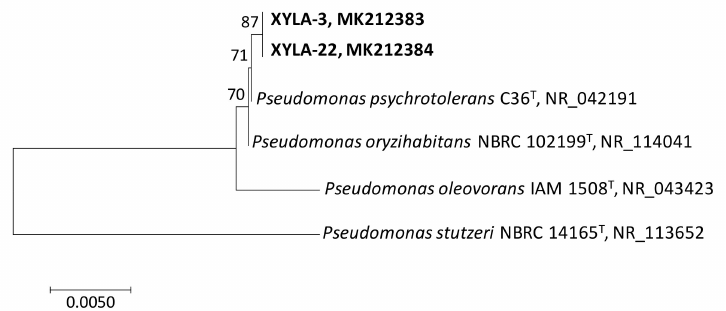
Figure 3. Phylogenetic position of the most effective xylanolytic micro-organisms isolated from orange juice processing waste, based on bootstrapping of 1000 trees. Scale bar represents substitutions per nucleotide